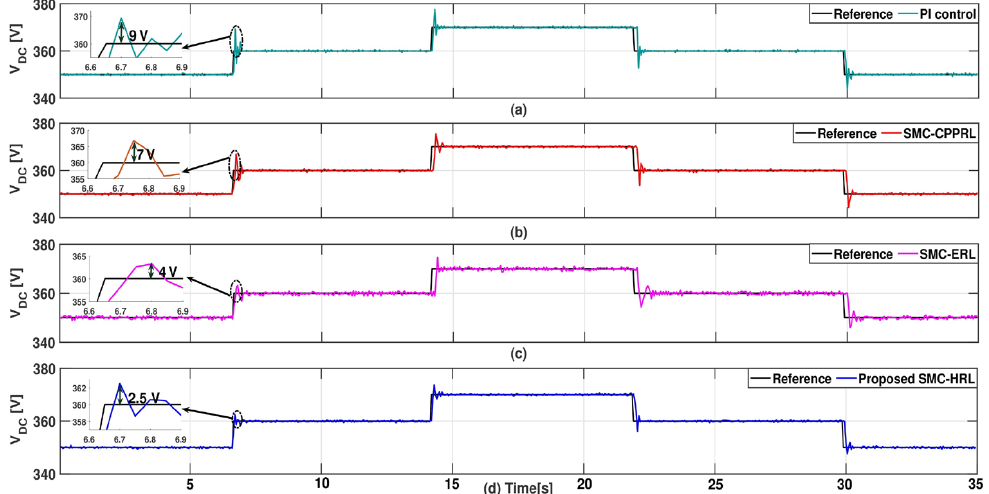
Figure 9. Experimental tracking responses of DC-link voltage under step-change in DC-link reference condition. ( a ) PI control. ( b ) SMC-CPPRL control. ( c ) SMC-ERL control. ( d ) Proposed SMC-HRL